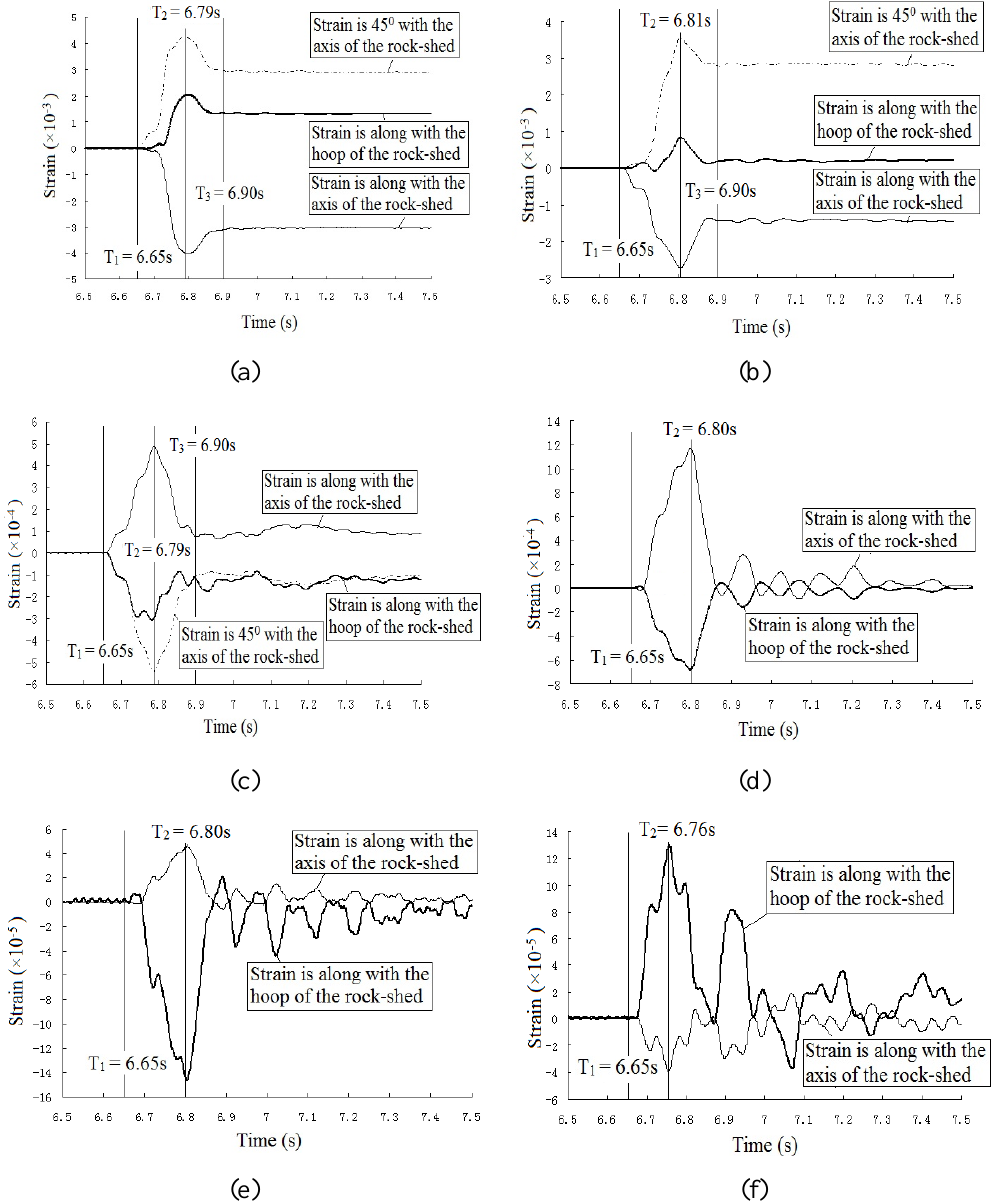
Fig. 7. The time-strain diagrams as recorded by the strain gauges. (a) Time-strain diagram at T0; (b) Time-strain diagram at T1-1; (c) Time-strain diagram at T1-2; (d) Time-strain diagram at T1-3; (e) Time-strain diagram at T1-4; (f) Time-strain diagram at T1-5